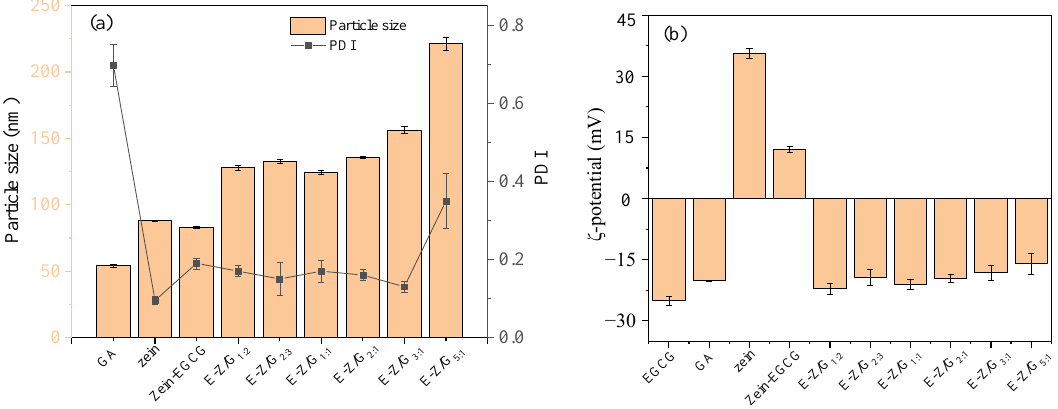
Figure 1. The particle size and PDI of different samples ( a ), and the zeta potential of different samples ( b ).